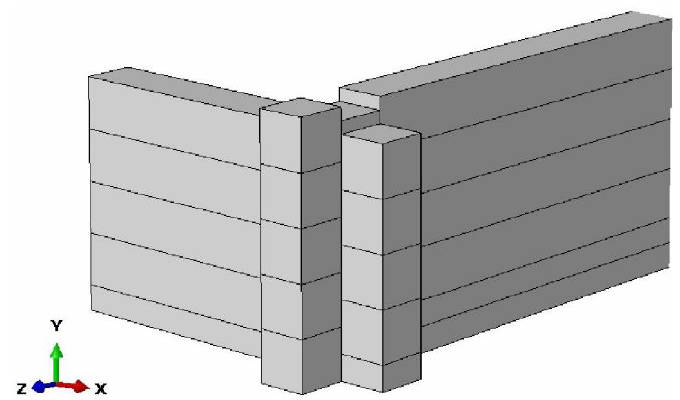
Figure 6. Corner joint detail of the typical Blockhaus FE model (ABAQUS, with hidden mesh).